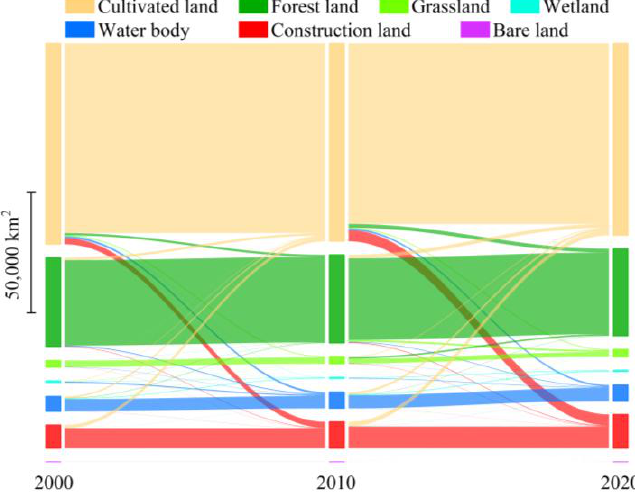
Figure 4. Sankey diagram of metrics for land use transfer in Anhui Province from 2000 to 2020.